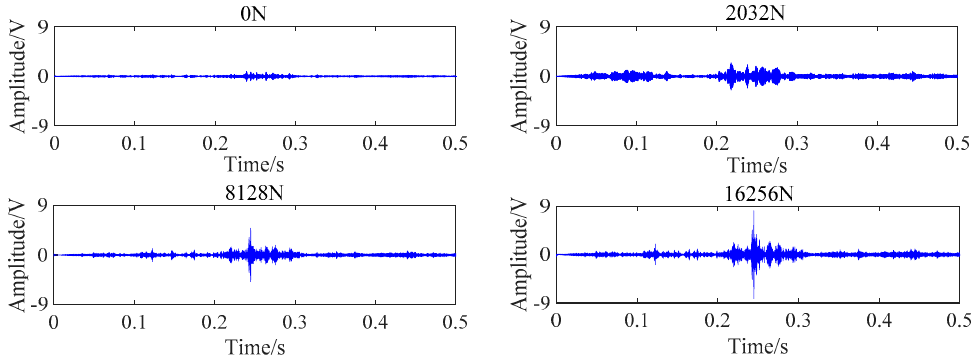
Figure 21. Received signal of PZT BC combination at six loading conditions.